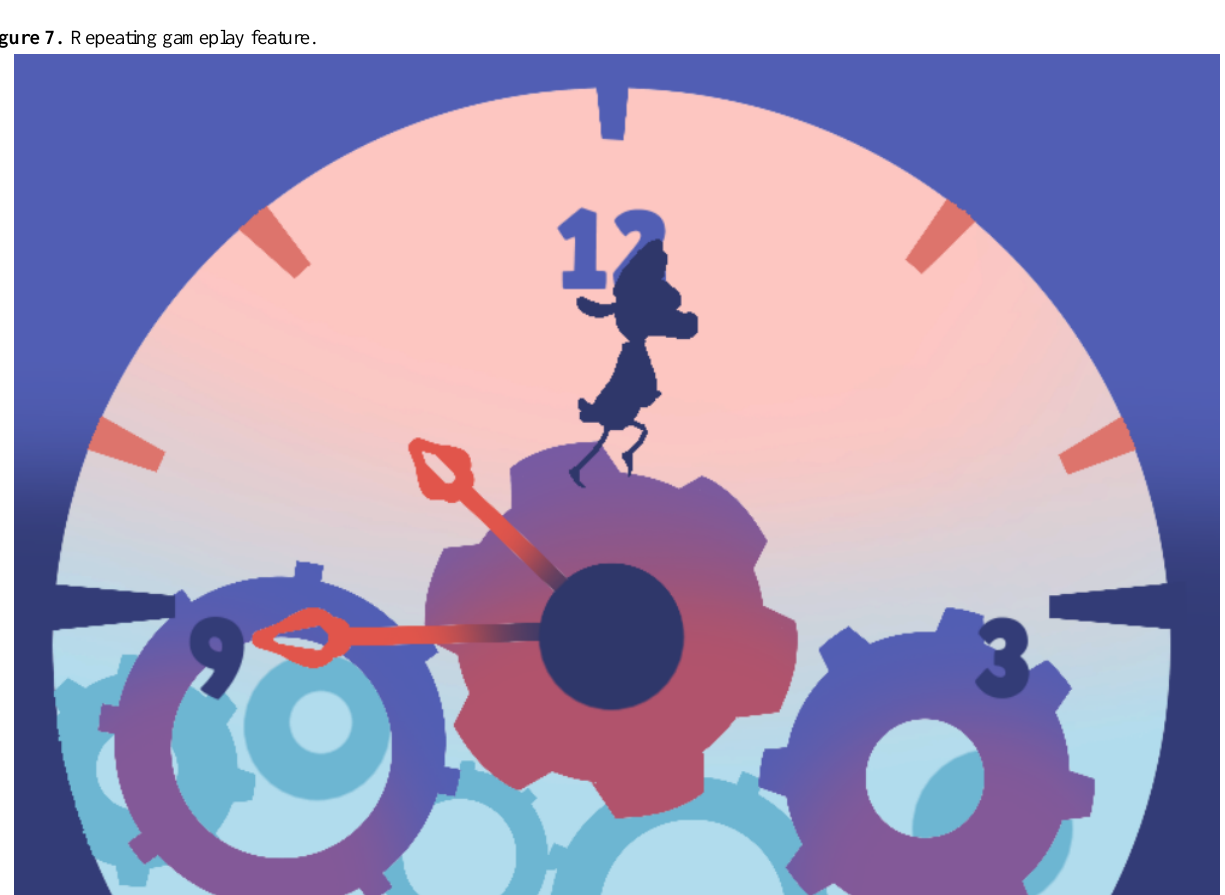
Figure 7. Repeating gameplay